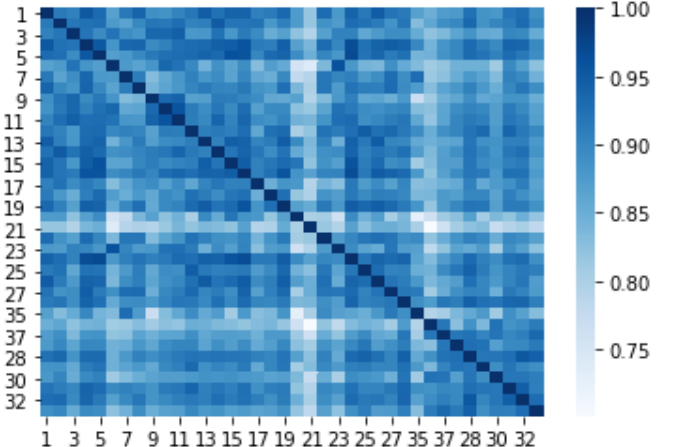
Figure 8. Correlation matrix across the 78 gene expressions (DNA microarray). Source: elaborated by the authors.